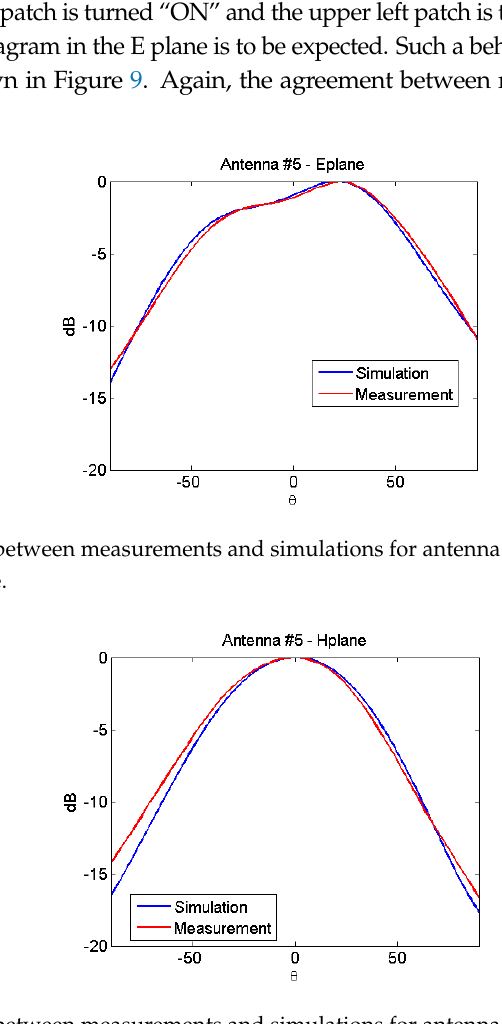
Figure 9. Comparison between measurements and simulations for antenna configuration (cid:93) 5 (upper left patch “OFF”)—H